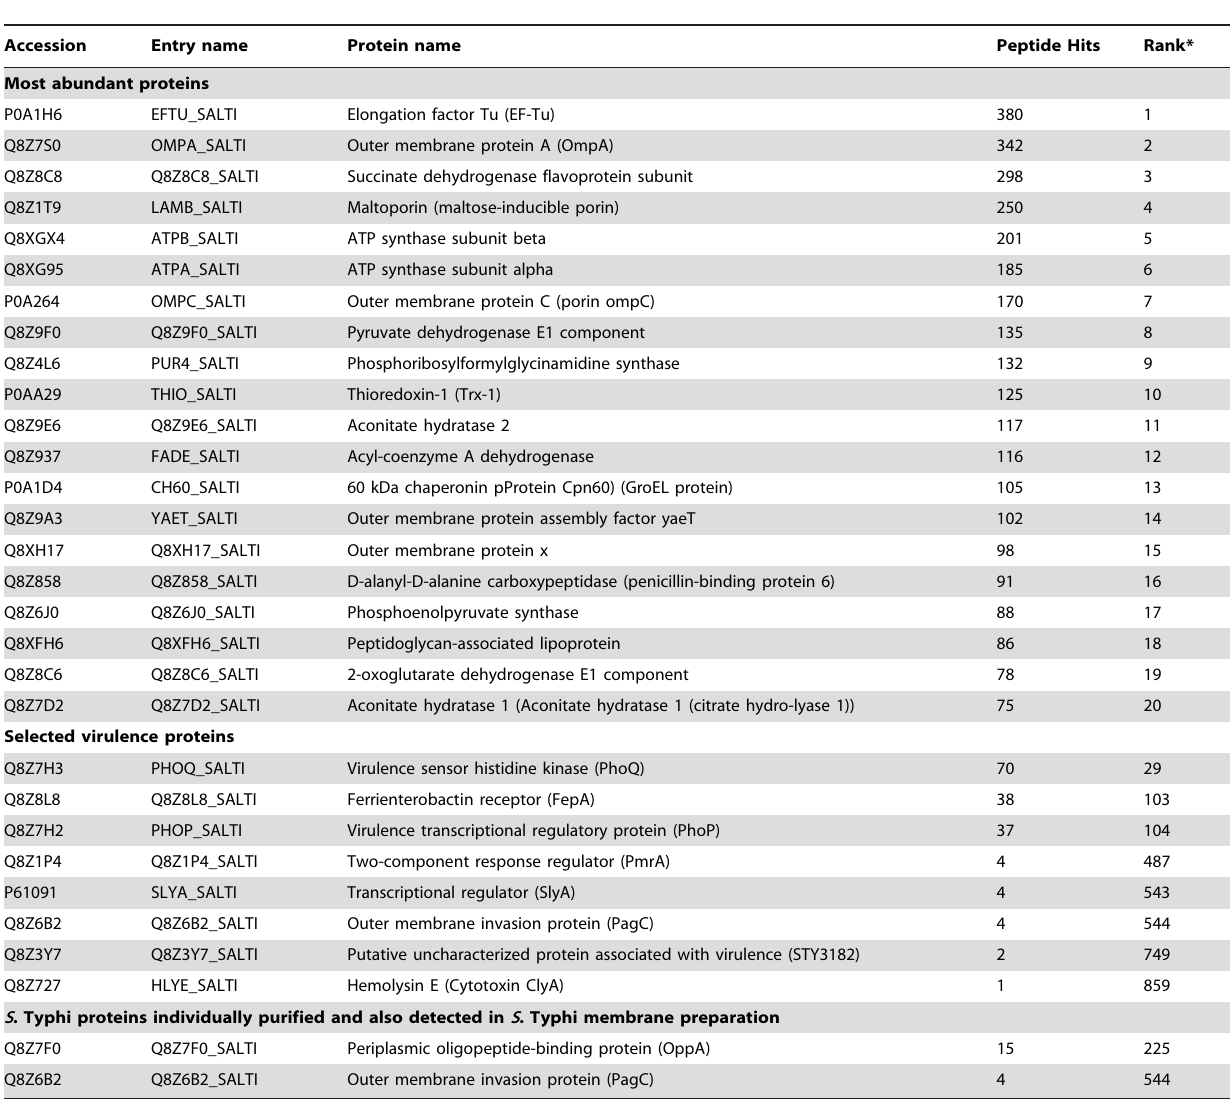
Table 3. Proteins represented in the S. Typhi membrane preparations and selected S . Typhi